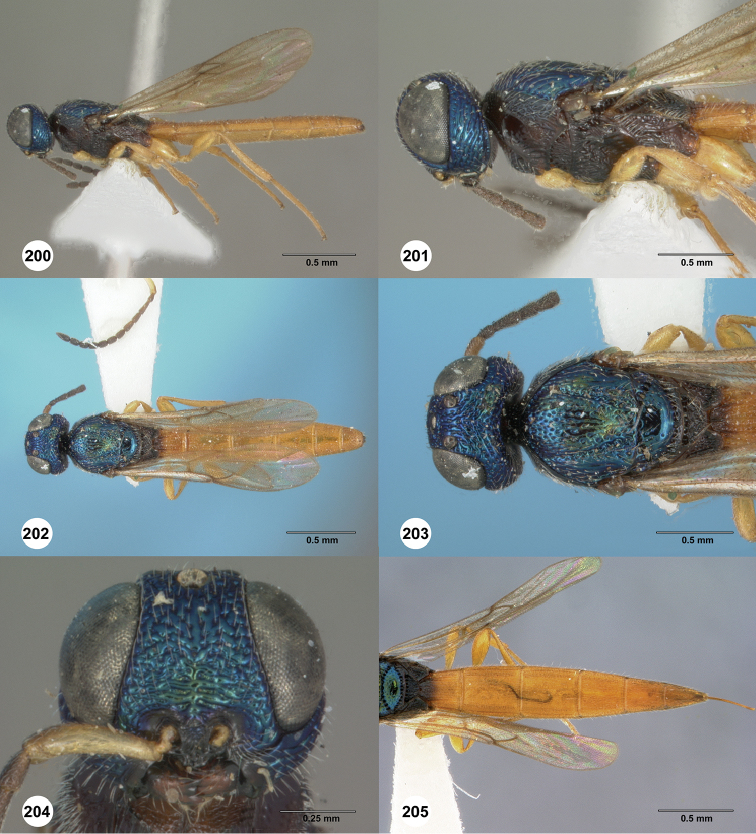
Chromoteleiasemicyanea Ashmead, male, holotype (USNM Type No. 2251). 200 Lateral habitus 201 Head and mesosoma, lateral view 202 Dorsal habitus 203 Head and mesosoma, dorsal view 204 Head, anterior view 205 female (OSUC584765) Metasoma, dorsal view.